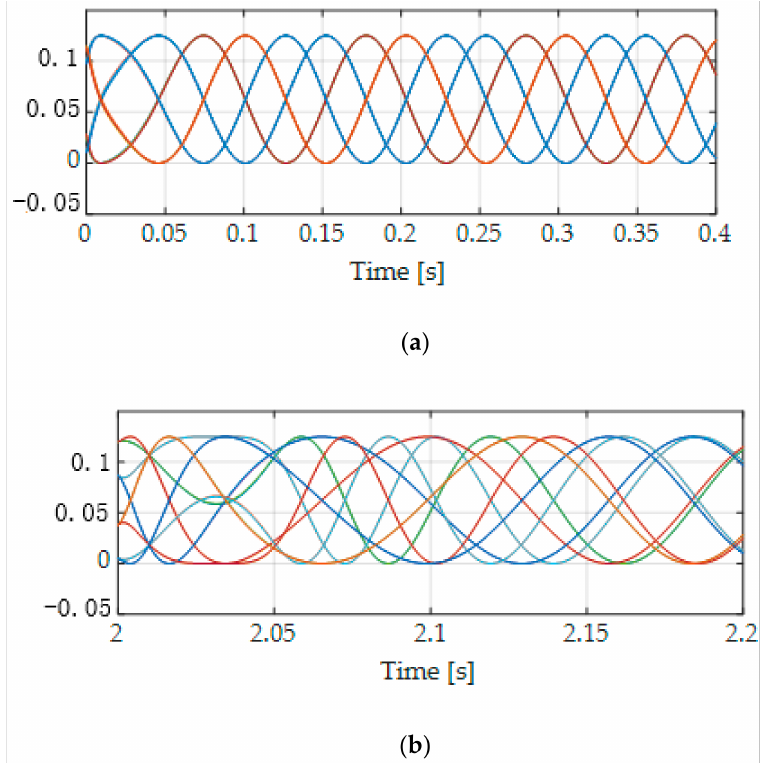
Figure 4. Sixteen interpolation parameters of the LPV control system. ( a ) Zoom-in X-axis at the start time of 16 interpolation parameters. ( b ) Zoom-in X-axis at 2 s of 16 interpolation parameters.